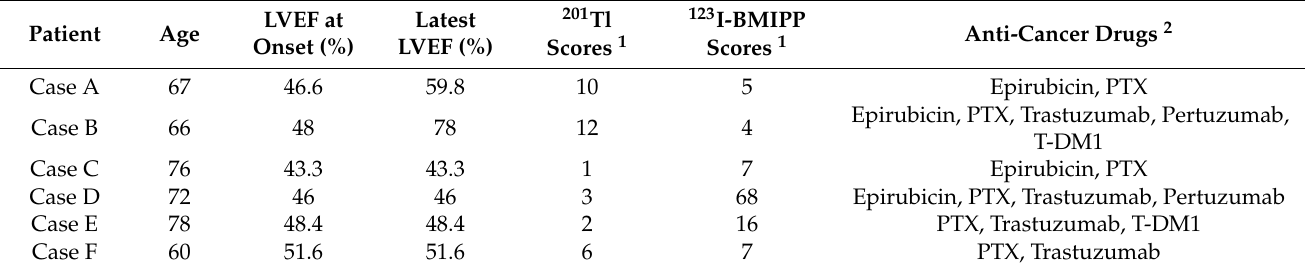
Table 3. Patients diagnosed with CTRCD.